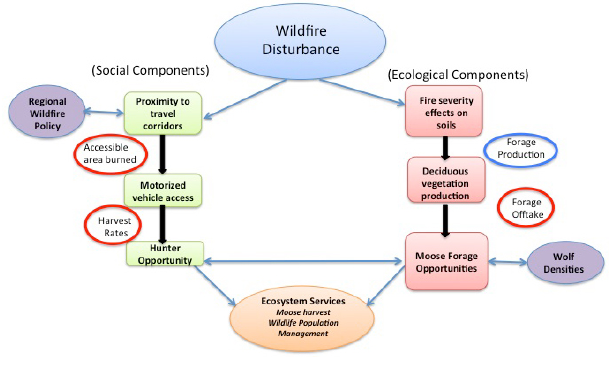
Fig. 1 . Diagram of the social and ecological components in a moose–hunter system following a wildfire disturbance in interior Alaska. Arrows represent the interactions between components. Research in our system focused on a slow variable (oval with blue outline) and fast variables (ovals with red outline). Purple ovals represent exogenous variables that can also affect system components.